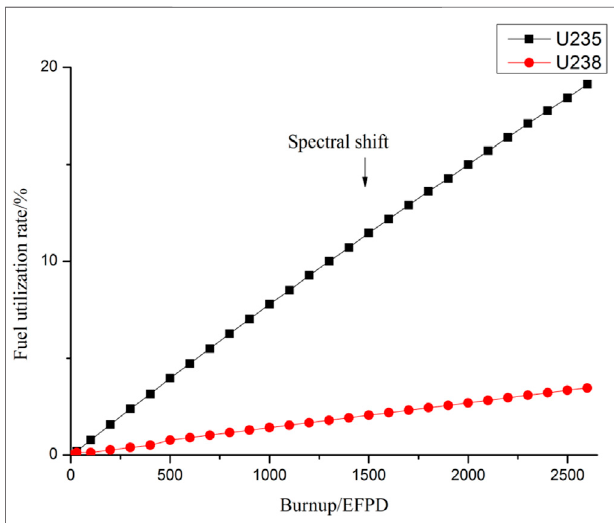
FIGURE 11 | Nuclide density variation in 200 EFPD for several typical fuel nuclides in the burnup.